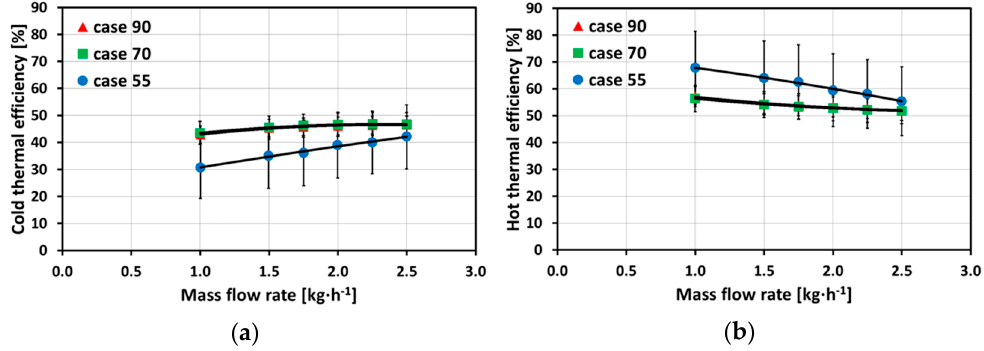
Figure 5. Thermal efficiency for cold fluid flow ( a ) and hot fluid flow ( b ) for case 90, case 70, and case 55 (with a maximum uncertainty of Δ ε Th = ±13.6% for the hot thermal efficiency and case 55).